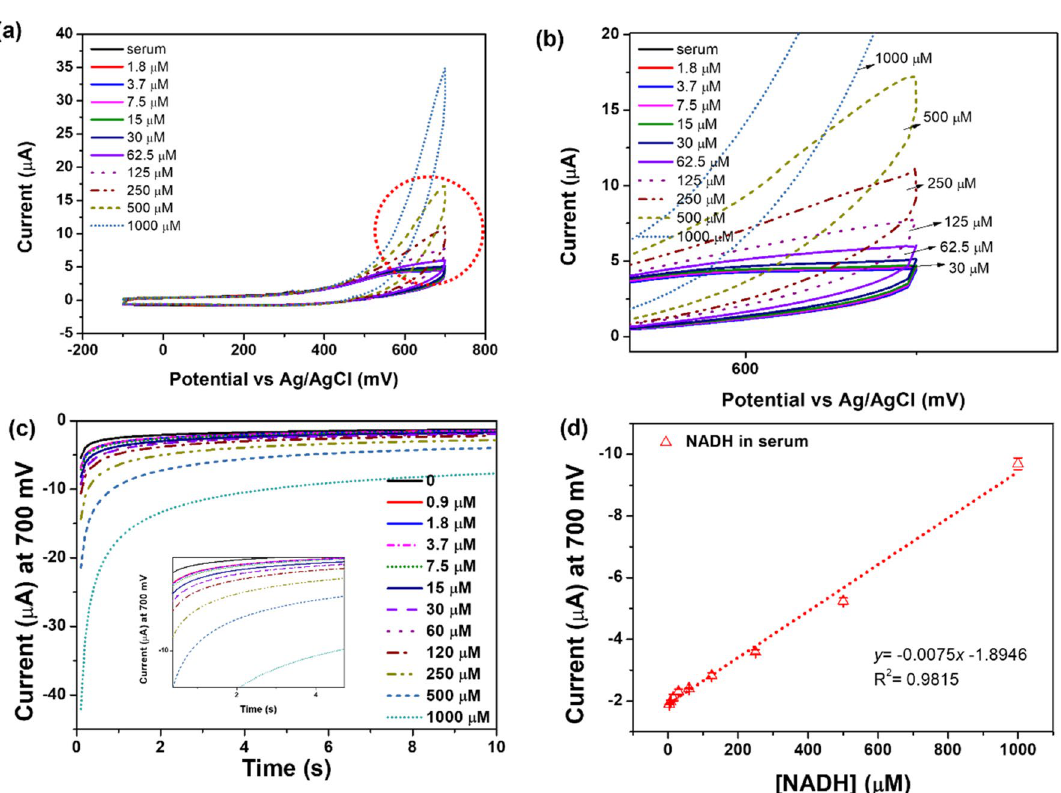
Figure 2. ( a – d ) Electrochemical results for NADH in the mouse serum. ( a ) Voltammogram results (potential range: from − 100 to 700 mV). ( b ) CV from the circled part of graph ( a ). ( c ) NADH quantification measured by CA. ( d ) Calibration plot of NADH in the mouse serum (0–1000 µM) (n = 5). The current at 10 s in the CA graph was used for NADH